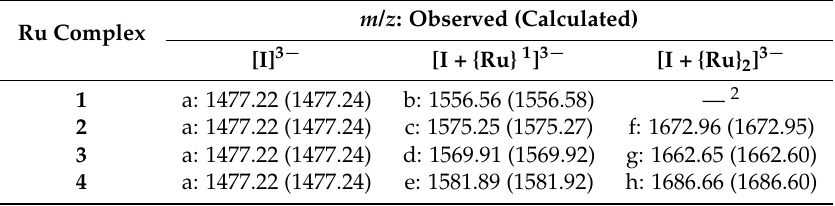
Table 2. Equilibrium binding constants ( K ) for the reactions of complexes 1 – 4 with strand I . Ru Complex K 1 (10 4 M − 1